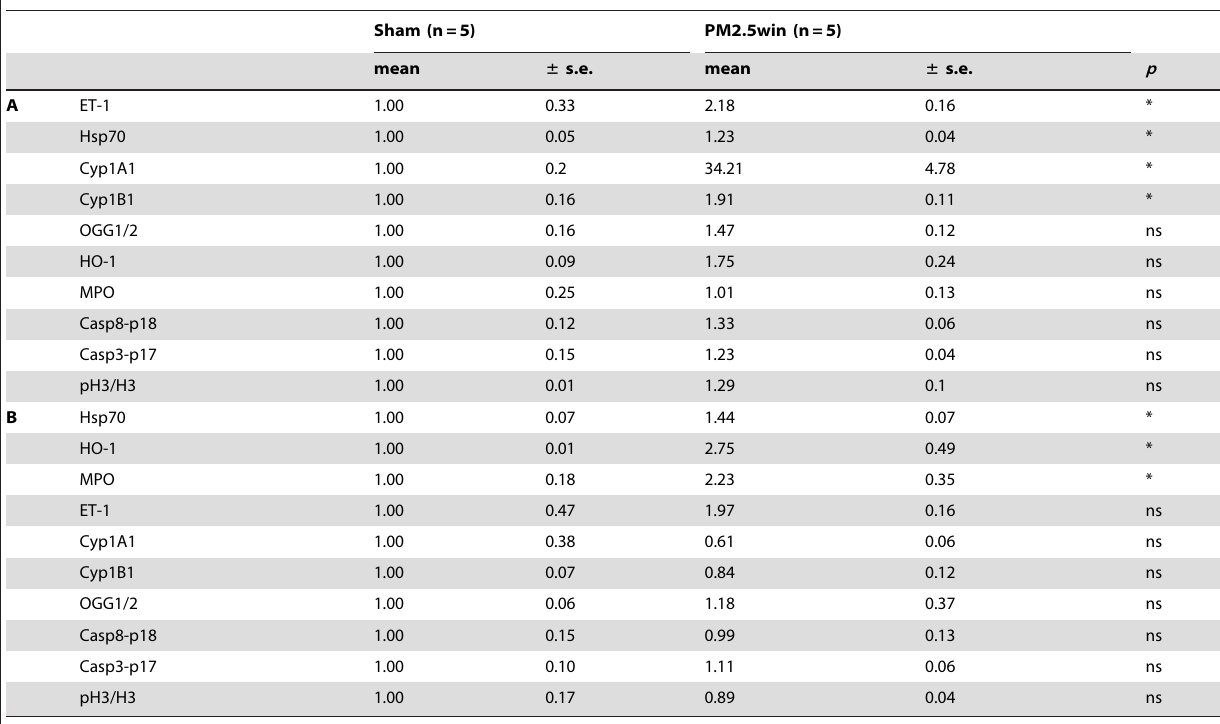
Table summarizing results in protein markers analyses in lung (A) and heart (B) in sham (n=5) and PM2.5win-treated mice (n=5), 24 h after the last intratracheal instillation; the data were normalized for the corresponding b -actin signal in each lane and expressed in relative to sham value. The data are expressed as mean 6